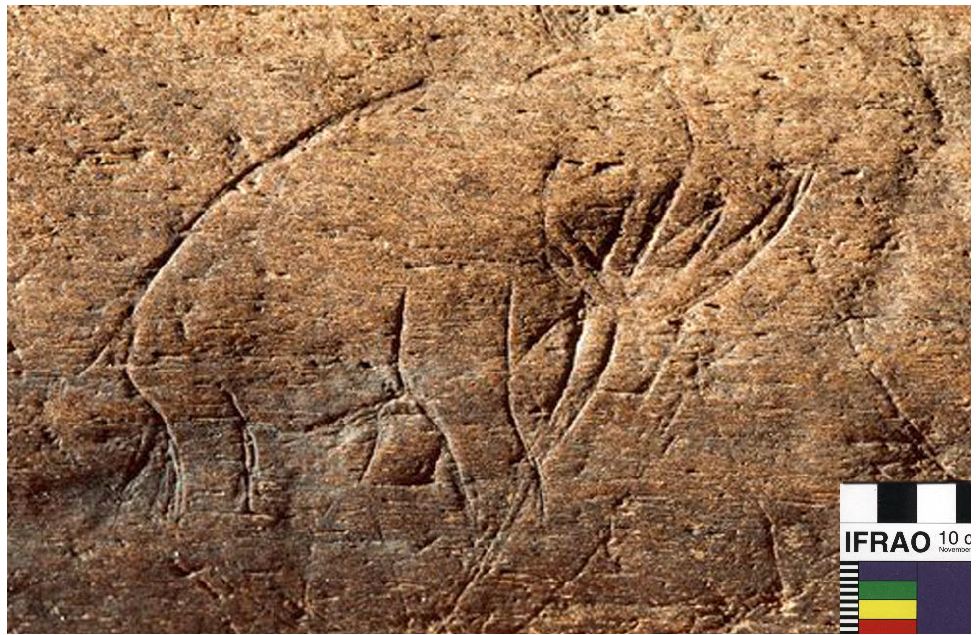
Figure 2. Engraving on a fossil bone fragment from Vero Beach, Florida, bearing a proboscidean